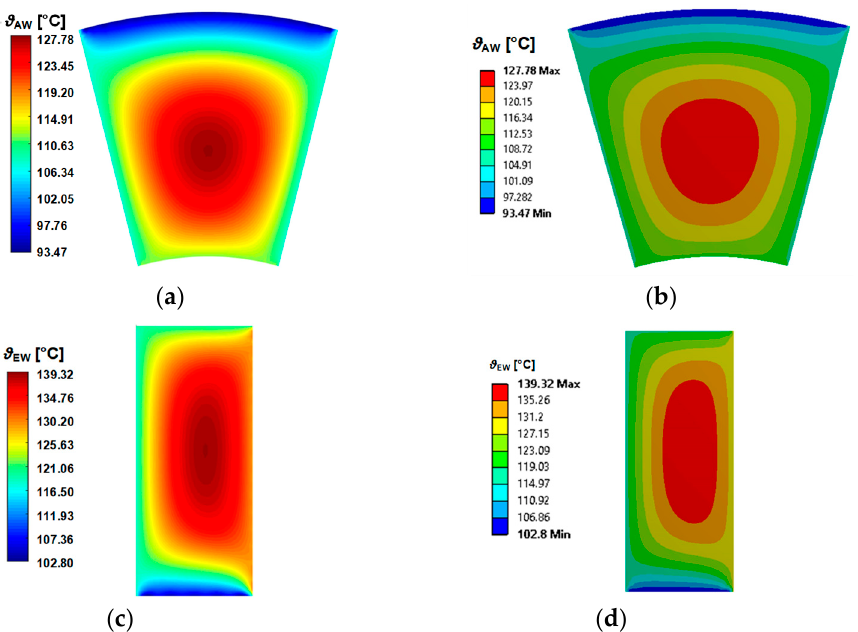
Figure 25. Steady-state winding temperature distributions predicted by ATMs and FEA [66]. ( a ) Active-winding (analytical). ( b ) Active-winding (FEA). ( c ) End-winding (analytical). ( b ) End-winding (FEA). Table 5. Comparison of steady-state average and hotspot temperatures of active-/end-windings pre- dicted by main thermal analysis methods [66].